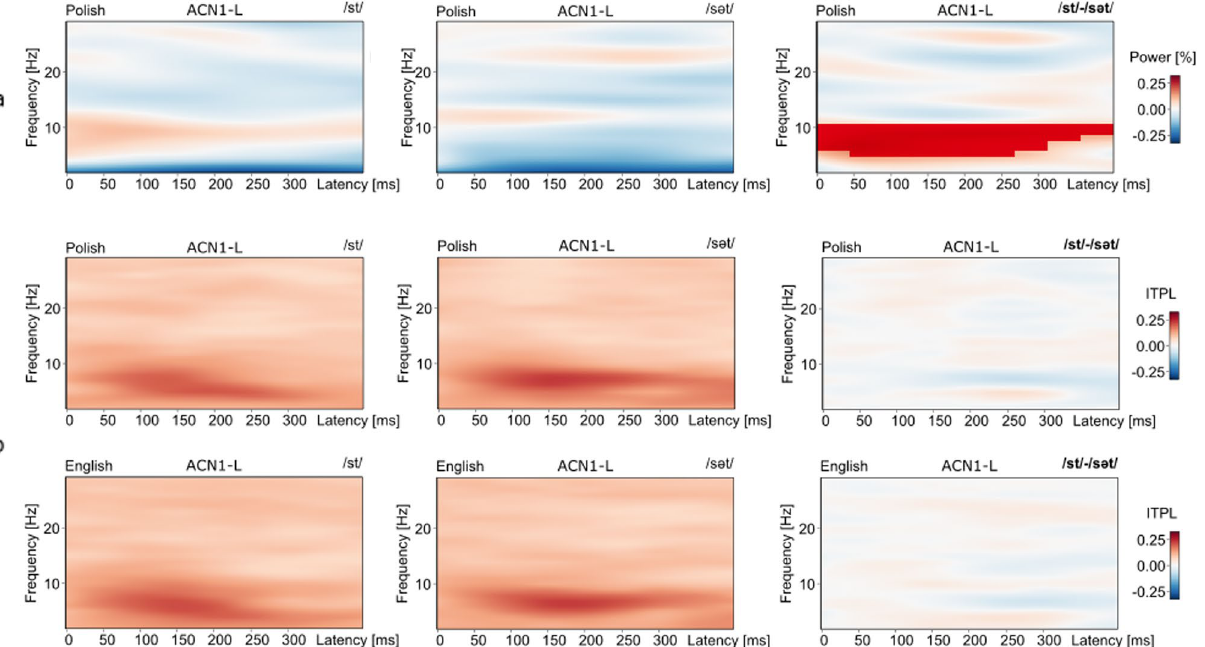
Figure 4. TSE and ITPL effects to the /st-s ə t/ contrast, attend condition. ( a ) Displays larger spectral power (TSE) in theta to the /st/ compared to the /s ə t/ onsets for only the Polish group from the ACN1-L source. The mask within the figure on the far right displays the reduced power to the rare /s ə t/ phonotactic form in the Polish language in high theta (5–10 Hz, max 9 Hz, 0–400 ms, p = 0.009). ( b ) For comparison, significant ITPL effects in theta were not found for either the Polish (top, p = 0.24) or English (bottom, p = 0.61) group from the ACN1-L source in response to the /st-s ə t/ contrast for the attend